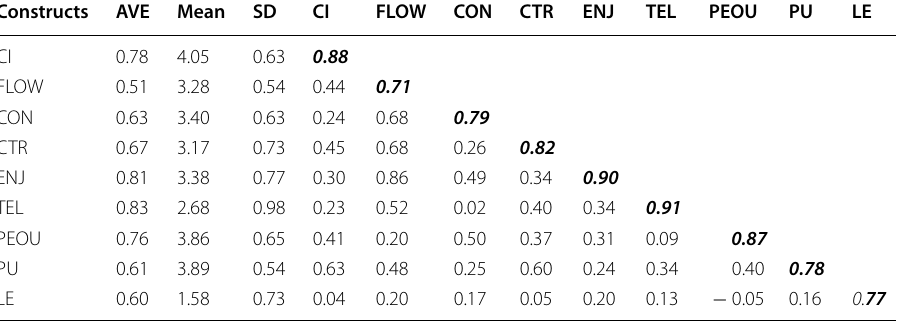
All correlations were significant at p < 0.001. Diagonal elements are square roots of average variance extracted; off‑diagonal elements are correlations